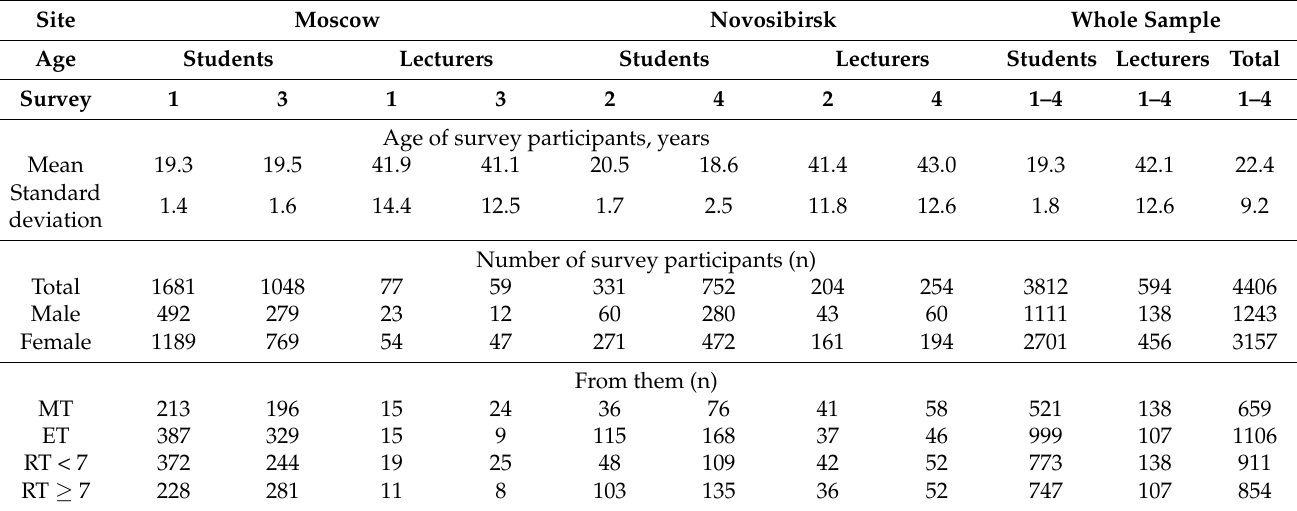
Table 1. Participants of four online surveys and their divisions into early and late